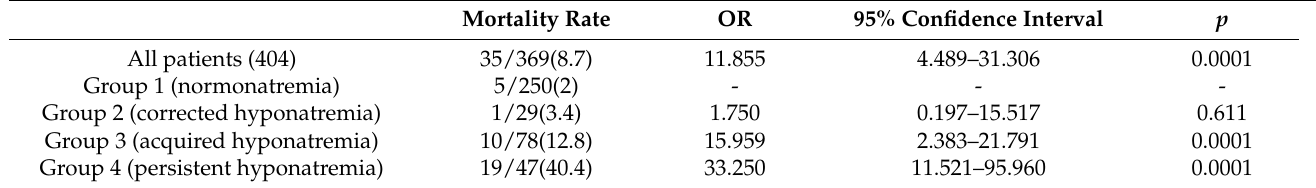
Table 3. Association between hyponatremia and mortality in patients with pulmonary embolism